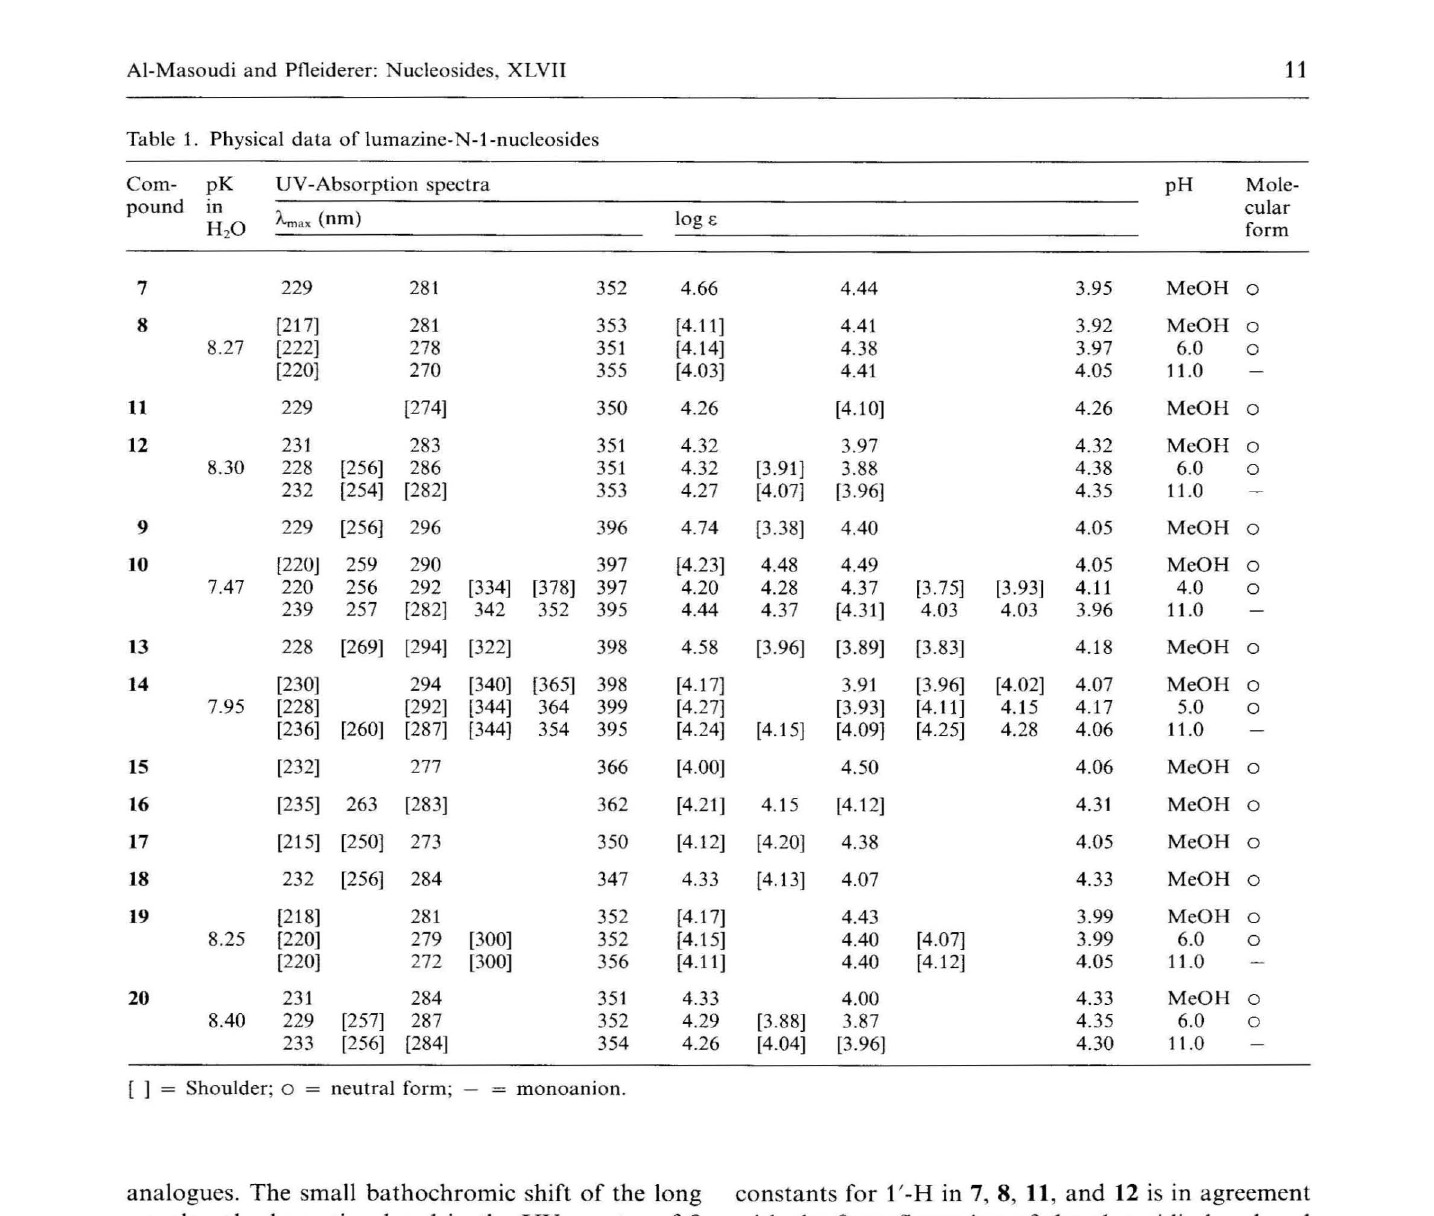
Table 1. Physical data of lumazine-N -l-nucleosides Com- pK UV -Absorption spectra pound In Amax (nm) log!': H 2 O